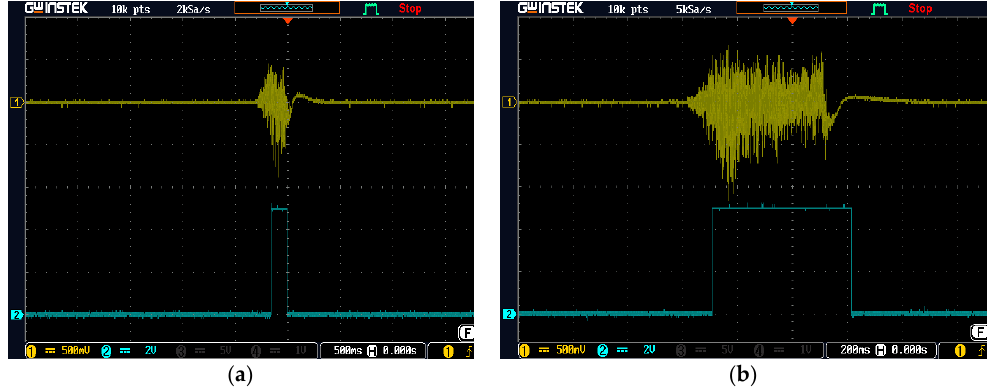
Figure 11. The waveforms of ( a ) a short blow, and ( b ) a long blow.